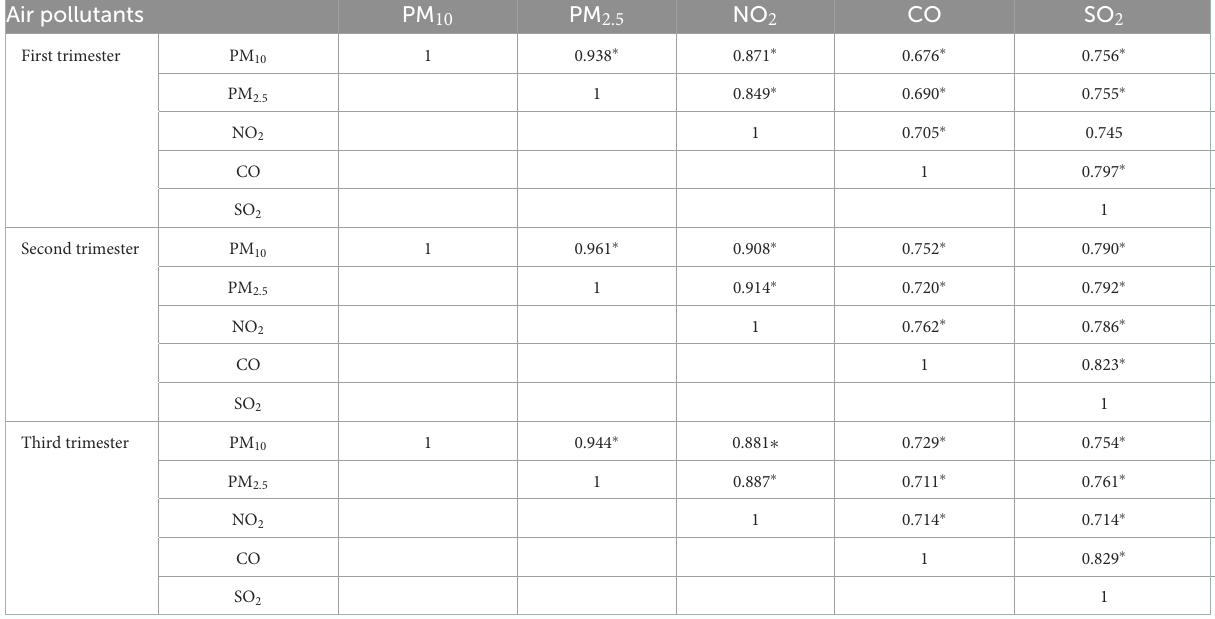
TABLE 4 Pearson correlation between exposures to air pollutants during different gestation. Air